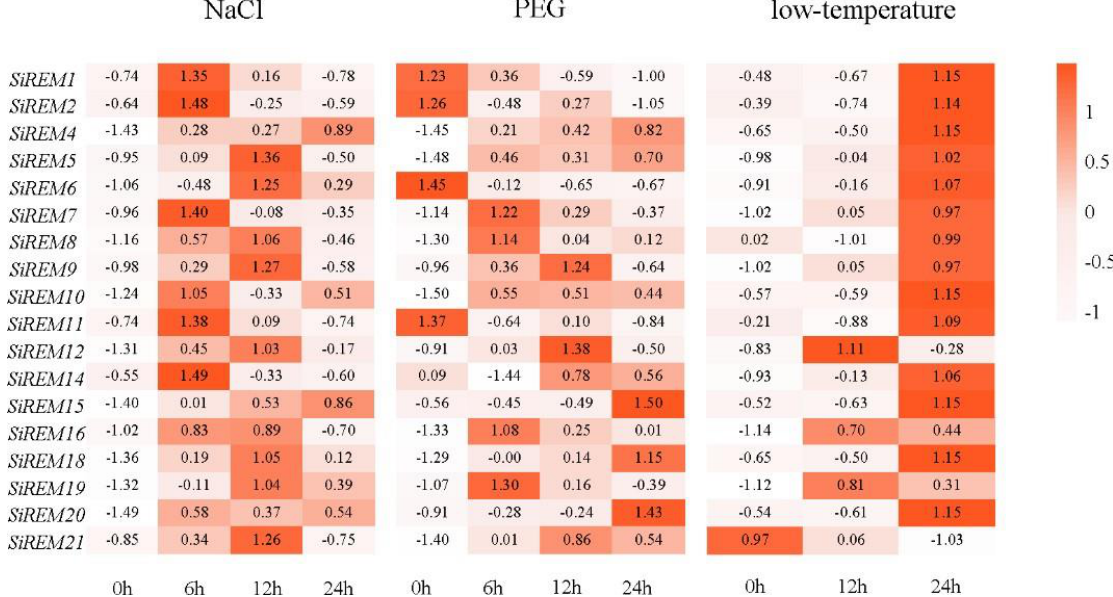
Figure 7. Expression profile of SiREM genes under different abiotic stress conditions. Orange bars indicate up-regulation, white bars indicate down-regulation, and the intensity of the color indicates the intensity of expression.